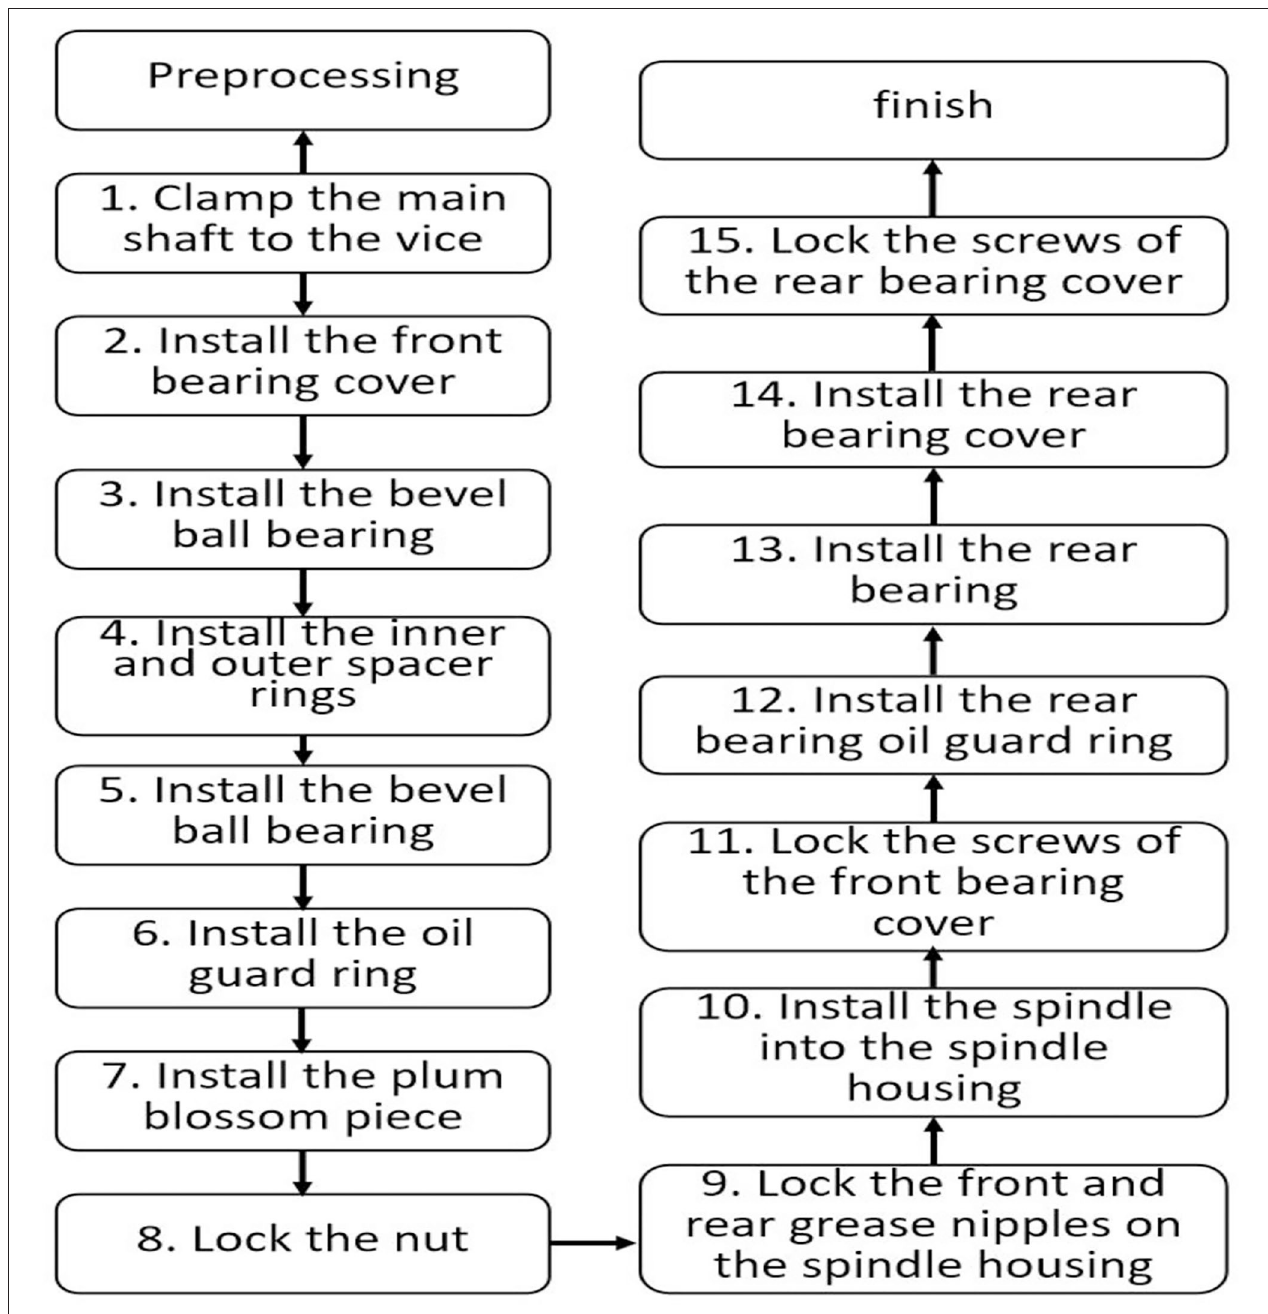
FIGURE 14 | Flow chart of giant axis group